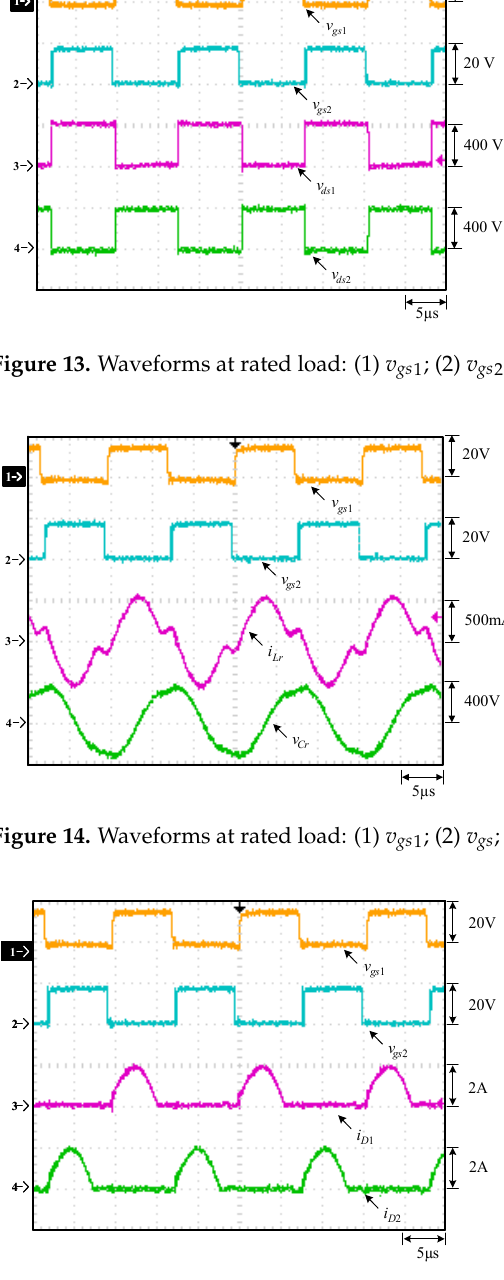
C 1 V C 1 i Figure 16. Waveforms at rated load: (1) v gs 1 ; (2) v gs 2 ; (3) V C 1 ; (4) i C 1 .